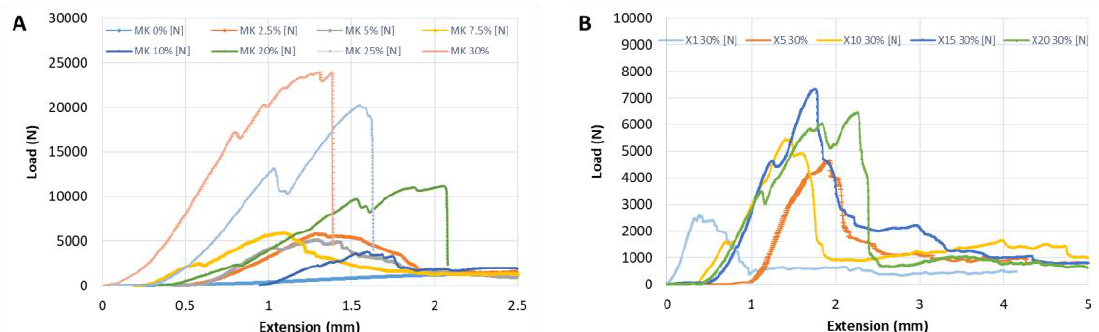
Figure 3. ( A ) Resistance to load of stabilized Loess soil with different contents of Metakaolin (MK, 0–30%) in an activation solution containing sodium silicate and NaOH (Group 1, Table 2). ( B ) Resistance to load of stabilized Loess soil with calcium oxide (CaO) as a substitute for NaOH in the activation solution (Group 2, Table 2). The results are CaO at the same amount as the NaOH (X1), which was used in the geopolymer presented Figure 3A, and with enlarged amount of CaO up to 20-times (X5-X20). The content of the Metakaolin was 30% for all samples in Figure 3B.